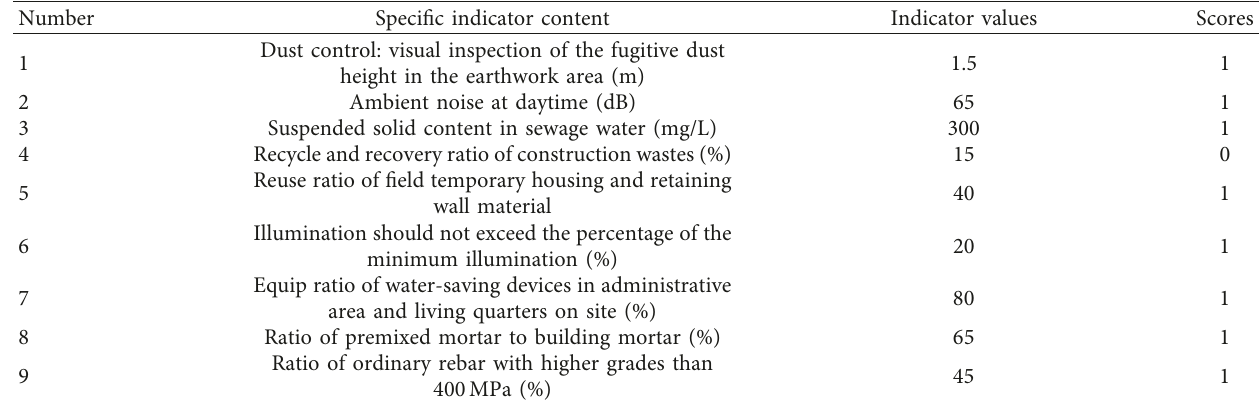
Table 10: SPARQL query on indicators with scores less than 2